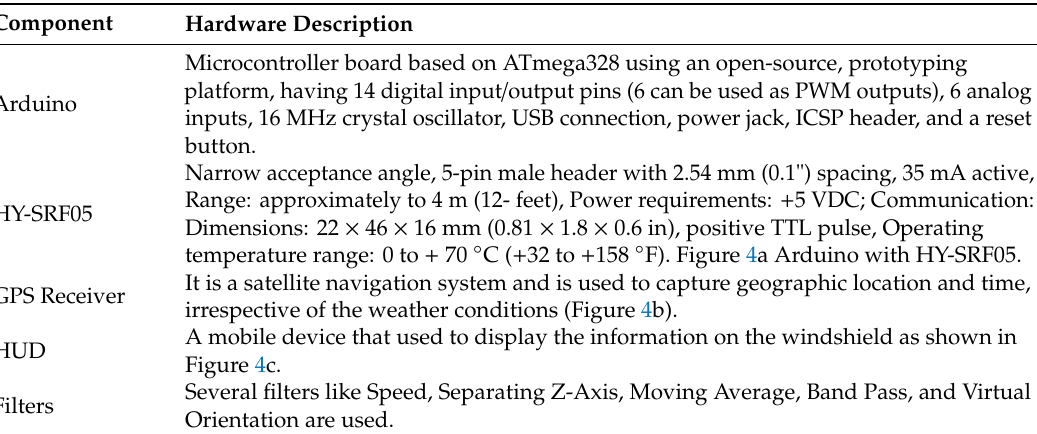
Table 1. The hardware specification of the proposed framework.